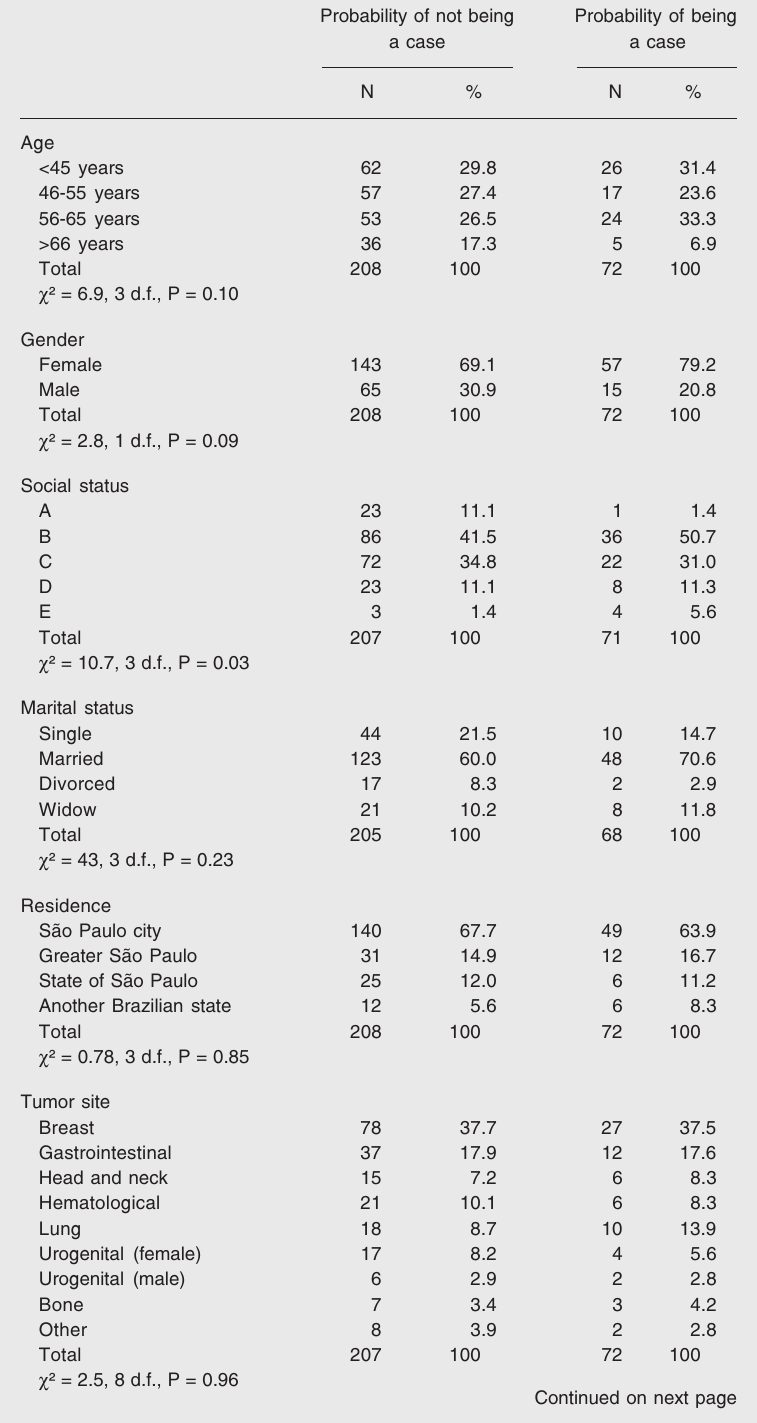
Table 1 Demographic and medical characteristics of the patients according to the probability of being or not being a psychiatric case in the Self Report Questionnaire-